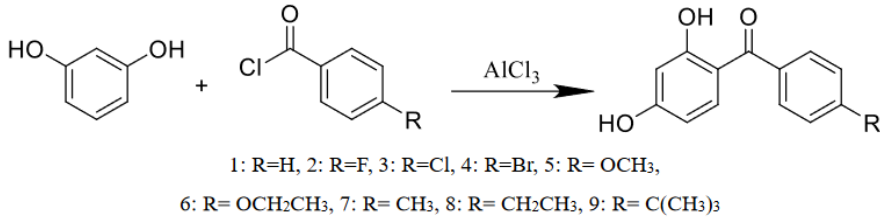
Figure 1. Pretreatment process of cotton fabric.